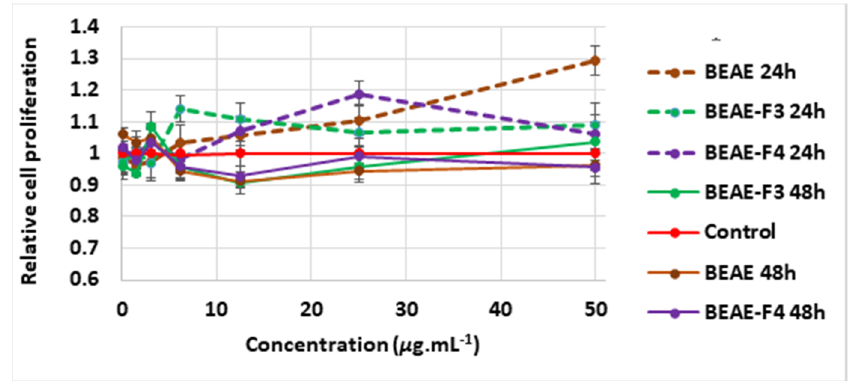
Figure 5. Cell-proliferating effect of C. inophyllum extracts, CEWE and CEAE, and resulting fractions CEAE-F3, CEAE-F4 and CEAE-F5 after 24 h and 48 h of treatment of dermal papilla cells at concentrations 0.1 to 50 µg.mL −1 normalized and compared to the control. Error bars represent SEM.